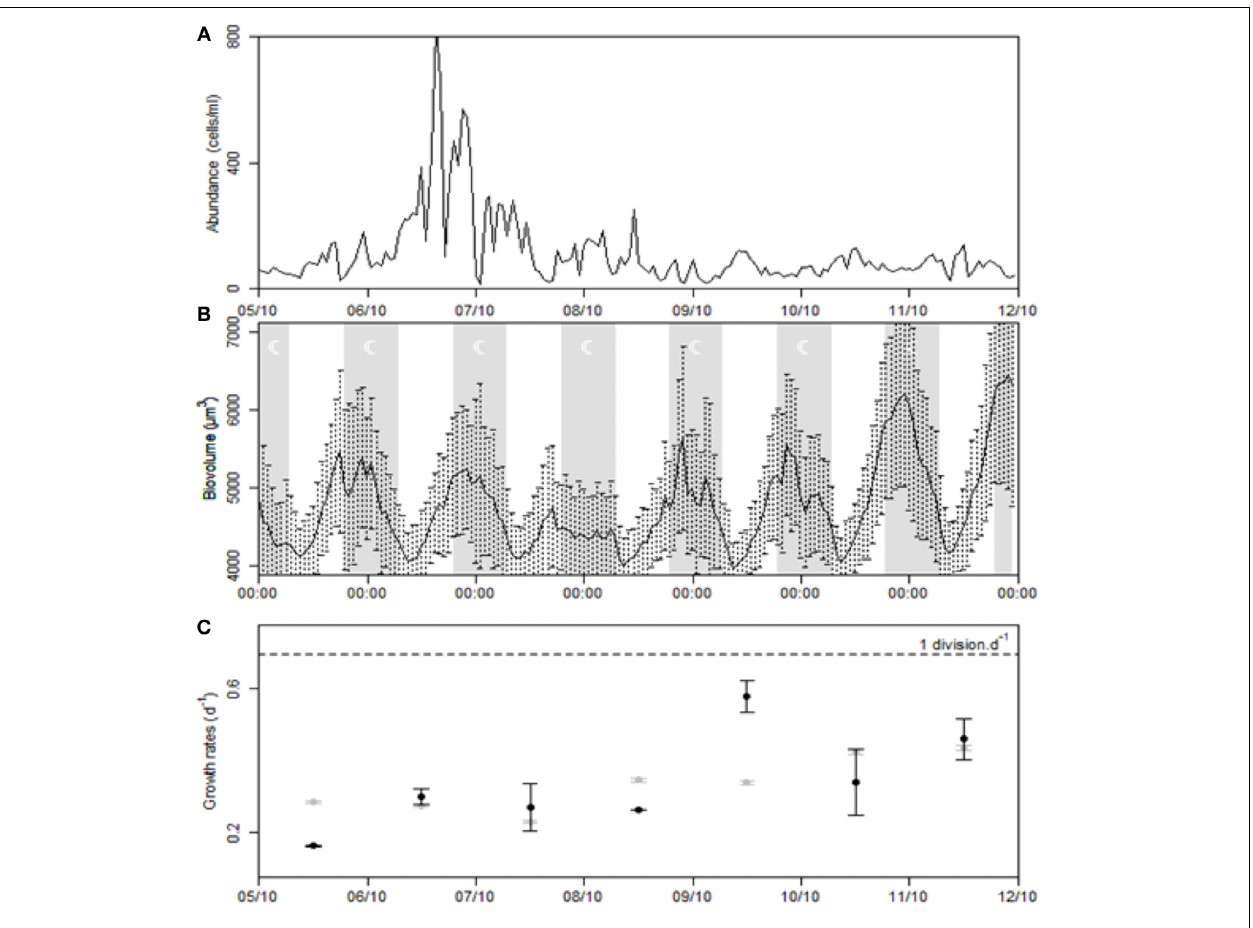
FIGURE 12 | Time series of the cluster C5 during the strong Mistral event. (A) Population dynamics. (B) Variation of the mean cells biovolume. (C) Estimations of the in situ growth rate provided by the ratio between